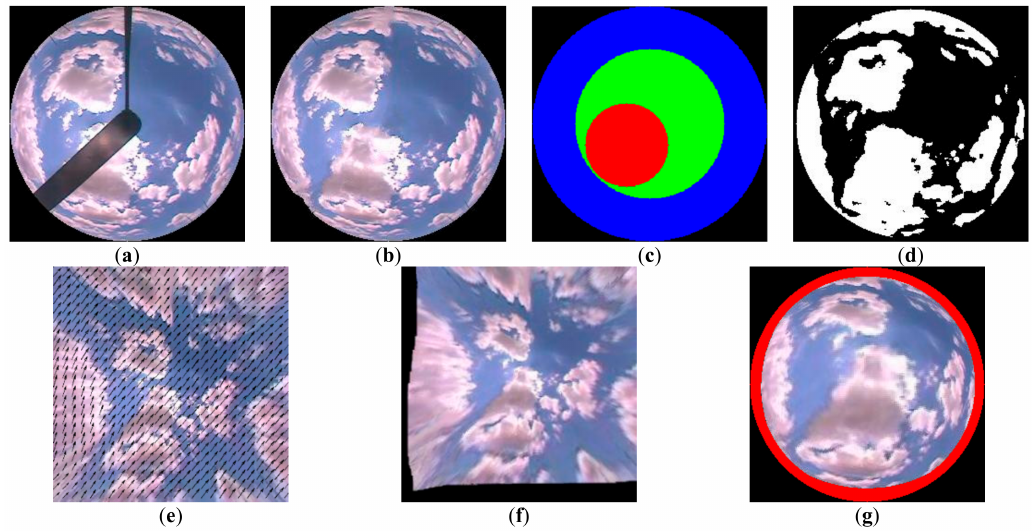
Figure 1. Main image processing steps: ( a ) Original 8-bit image; ( b ) interpolation image; ( c ) mask used for partitioning image into three regions to obtain local cloud classification thresholds; ( d ) cloud detection image; ( e ) image projected onto rectangular grid and velocity field computed by the optical flow method; ( f ) prediction image projected onto rectangular grid; ( g ) prediction image transformed from a rectangular grid to TSI image coordinates. The red region indicates the area that the prediction image cannot